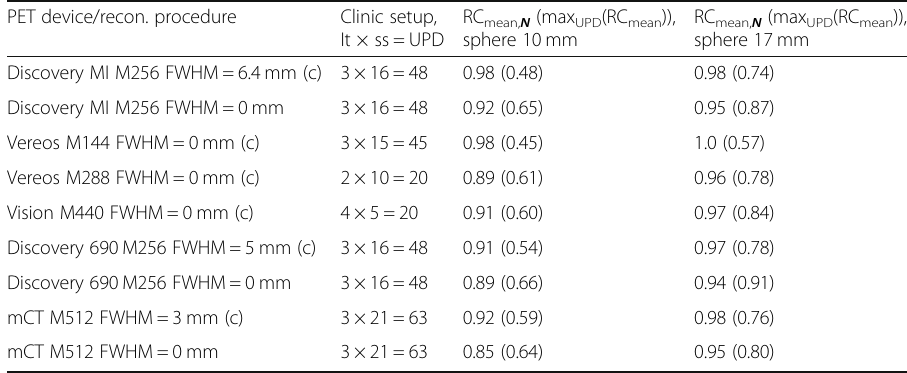
Table 4 Normalized RC mean for the number for iterative updates used in clinical reconstruction setups (and maximum RC mean values) obtained for the smallest sphere insert (diameter of 10 mm) and a medium size insert (diameter of 17 mm) characteristic of tested PET FDG procedures. Reconstruction protocol setups used in the clinic are labeled with (c) PET device/recon.